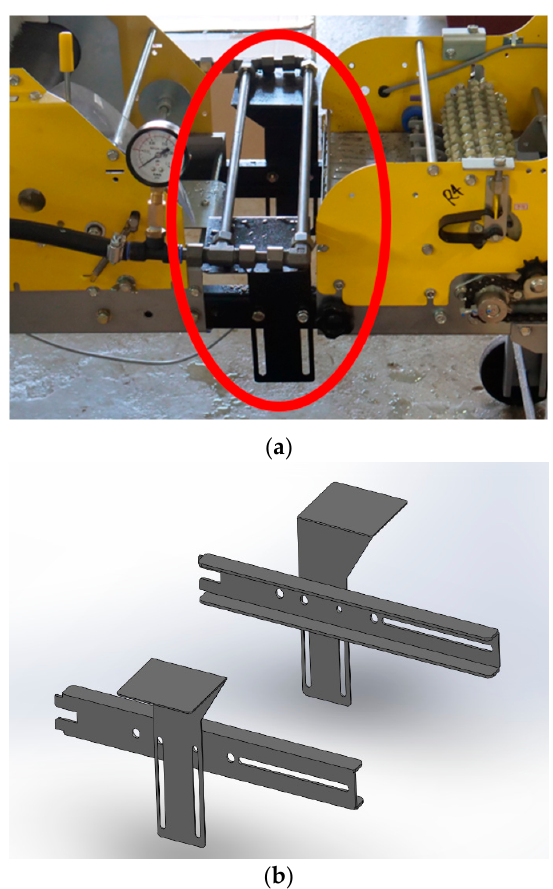
Figure 4. A view of the irrigation pipe: ( a ) position of the irrigation holes; ( b ) picture of the irrigation pipe.